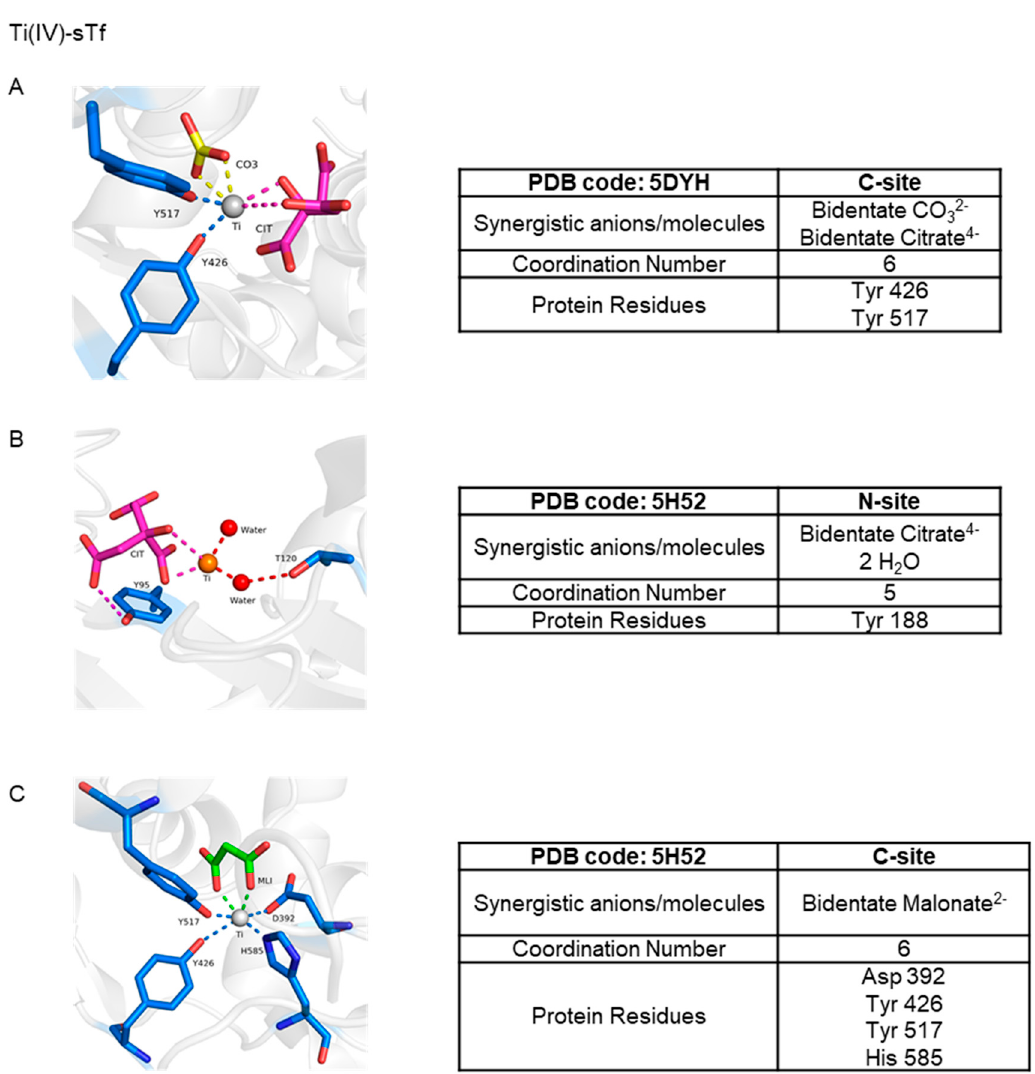
Figure 11. X-ray structures of Ti(IV) coordinated by sTf. Ti(IV) is observed bound in a semi-open conformation at the C-site ( A ) and the N-site ( B ) with citrate serving as a synergistic anion and in a closed conformation at the C-site ( C ) with malonate serving as a synergistic anion. Inorganics 2020 , 8 , x FOR PEER REVIEW